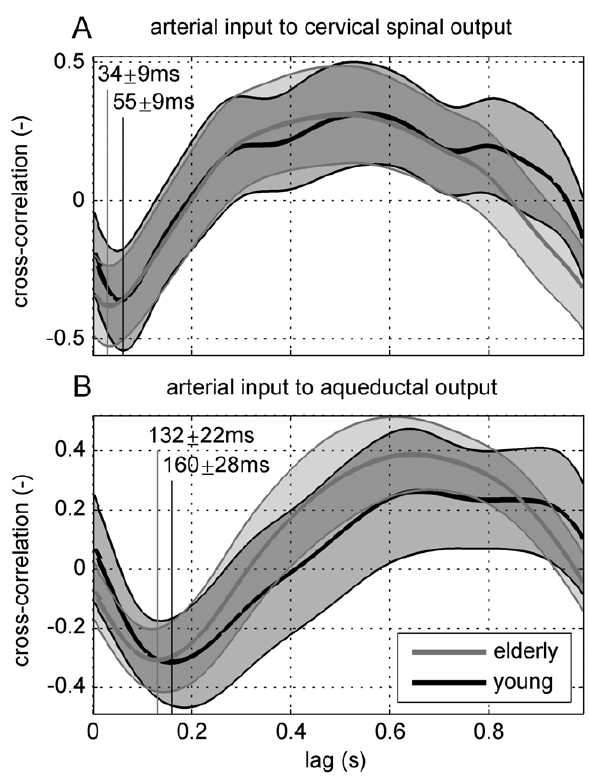
Figure 4. Cross-correlation of arterial input to cervical spinal A (at the level of C3–C4) and to aqueductal B cerebrospinal fluid flow, mean (bold line) and standard deviation (gray shading) of elderly (gray line) and young (black line) groups’ results. The vertical lines depict the mean delays from the maximum systolic peak flows to the maximum caudal flows in either CSF